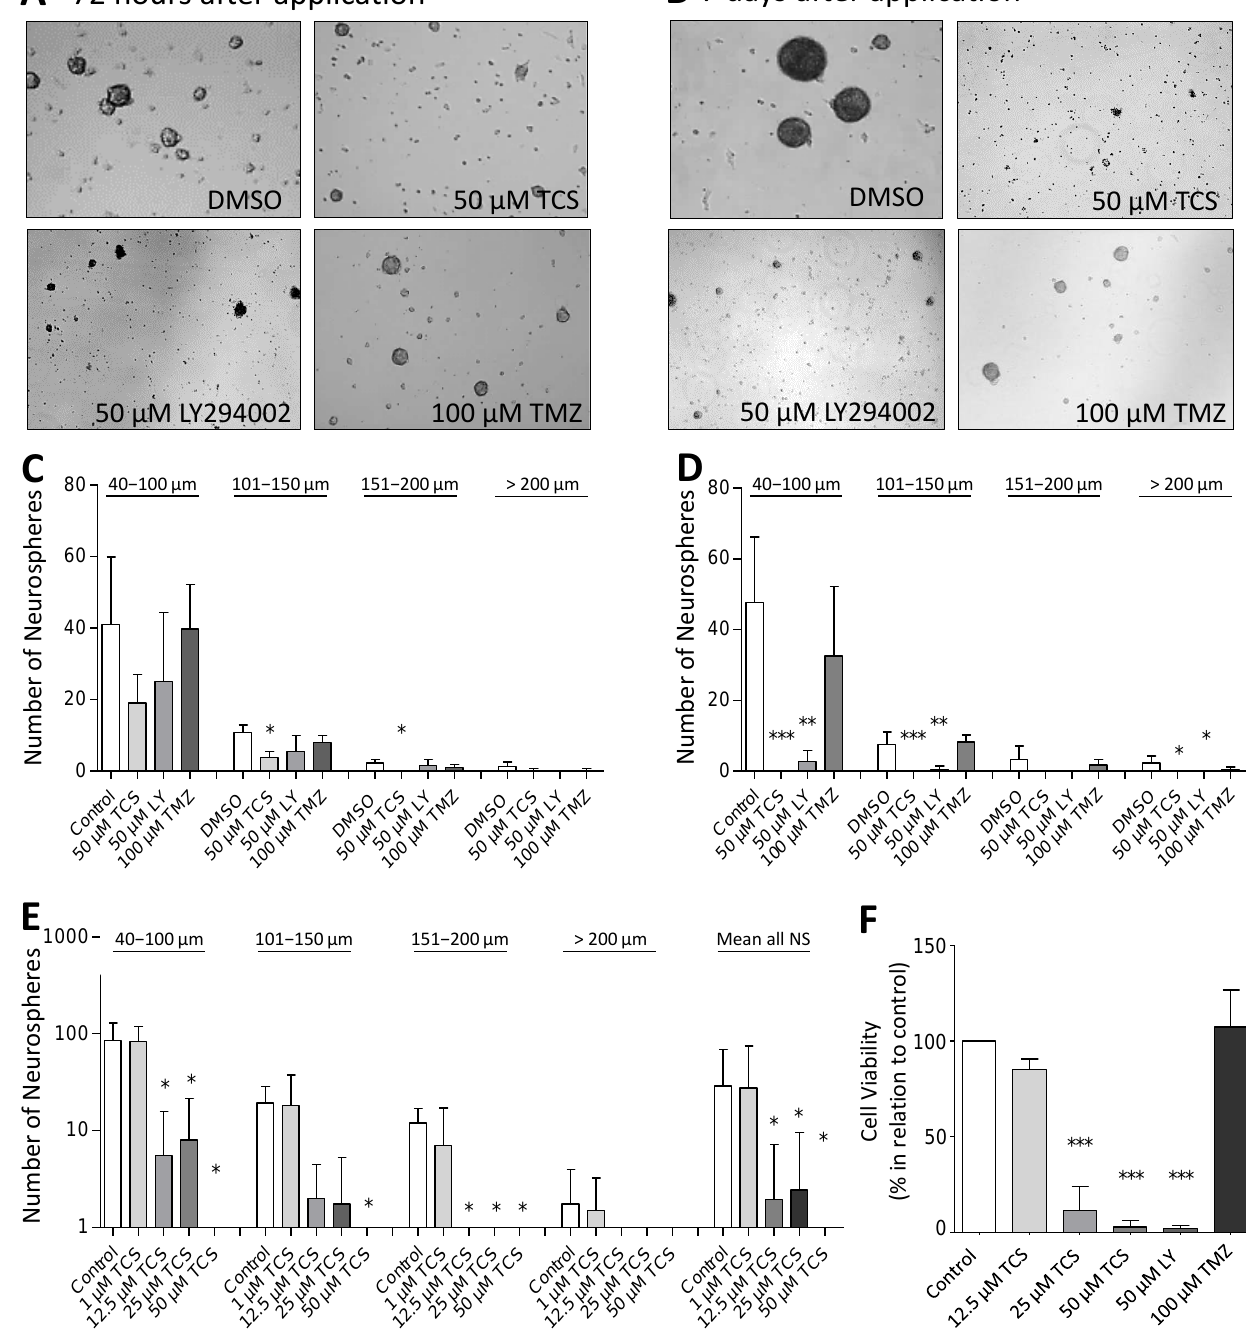
Figure 4. Pharmacological inhibition of PIM1 promotes loss of GBM cell viability and impairs formation of neurospheres. ( A , B ) PIM1 inhibition significantly impairs neurosphere formation. LN-18 cells were grown as neurospheres for 7 days before treatment with either the selective PIM1 inhibitor TCS PIM1-1 (TCS; 50 µM), the dual PI3K/PIM1 inhibitor LY294002 (50 µM) or temozolomide (TMZ; 100 µM), started for 72 h ( A ) or 7 days ( B ). Control cells were treated with the respective solvent DMSO. Representative images of neurospheres at the defined time points are shown. ( C , D ) Statistical analysis of the average sphere size after treatment with either the selective PIM1 inhibitor TCS PIM1-1 (TCS, 50 µM), the dual PI3K/PIM1 inhibitor LY294002 (LY; 50 µM) or temozolomide (TMZ; 100 µM) for 72 h ( C ) or 7 days ( D ). Neurospheres were subdivided according to their sizes in four groups (40–100 µm, 101–150 µm, 151–200 µm and >200 µm), which were separately investigated. Control cells were treated with the solvent DMSO. Columns represent means and SD of four independent experiments, significant differences for * p < 0.05, ** p < 0.005 and *** p < 0.001. ( E ) Growth characteristics of LN-18 neurospheres after application of increasing TSC PIM1-1 concentrations (TCS; 1, 12.5, 25 and 50 µM). Statistical